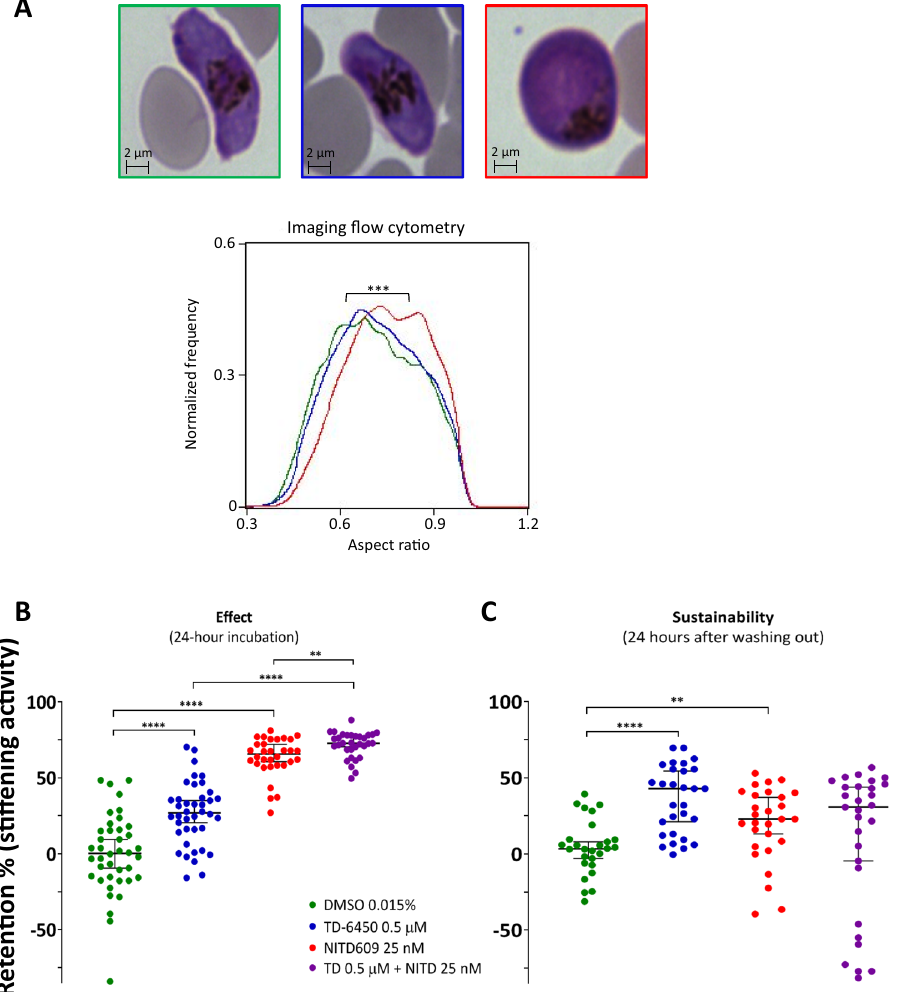
Fig. 4 | Activity of NITD609 and TD-6450 upon post-screening analysis. A Giemsa-stained erythrocytes infected by a mature gametocyte of P. falciparum exposed for 24hours to DMSO (negative control, green border), TD-6450 5 µ M (blue border) and NITD609 1 µ M (red border). Circularity of gametocytes by ima- ging fl ow cytometry was compared measuring the aspect ratio showing a sig- ni fi cant difference between DMSO and NITD609. The experiment was performed once. B Cumulative dot-plot of 5 microsphiltration experiments where stage V gametocytesof P.falciparum (3D7pULG8-GFPstrain)wereexposedfor24hoursto TD-6450 (blue), NITD609(red) or the combination of both (purple). C Cumulative dot-plot of 4 microsphiltration experiments where gametocytes were exposed to thedrugsfor24handkeptincultureforanadditional24hoursafterremovingthe drug. Dots indicate the retention rate of single wells of 96-well microsphiltration